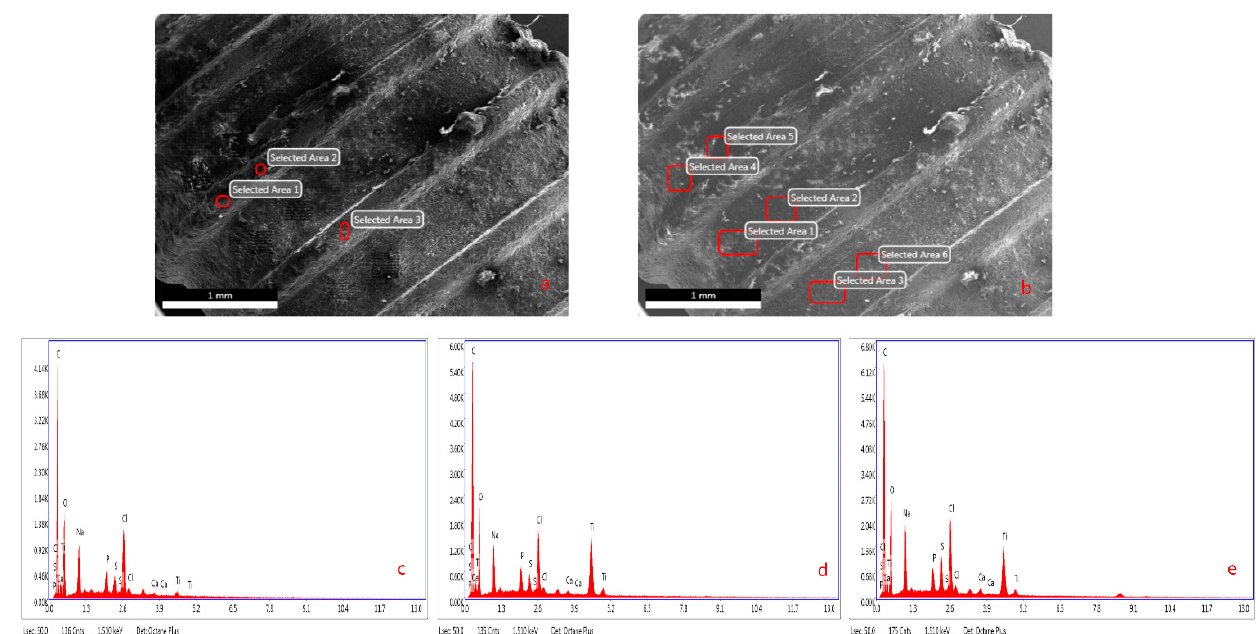
Figure 2. ( a,b ) SEM images on the top, valley, and flank parts of fixtures; ( c ) EDX analysis of the top parts; ( d ) EDX analysis of the valley parts; ( e ) EDX analysis of the flank parts of fixtures.